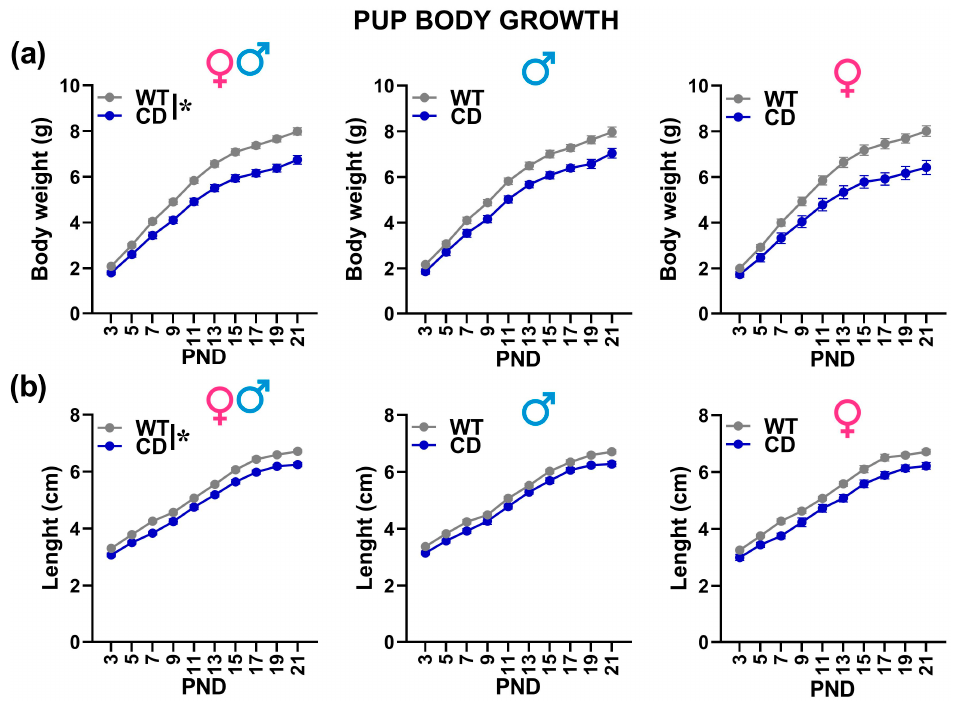
Figure 2. Body growth of mouse pups. Body weight ( a ) and length ( b ) were assessed during the first 3 post-natal weeks. * = p < 0.05 referring to a main genotype effect. Statistical analyses were not conducted separately in males and females since no significant interaction with sex emerged. n = 29 males (17 WT, 12 CD) and 27 females (16 WT, 11 CD).